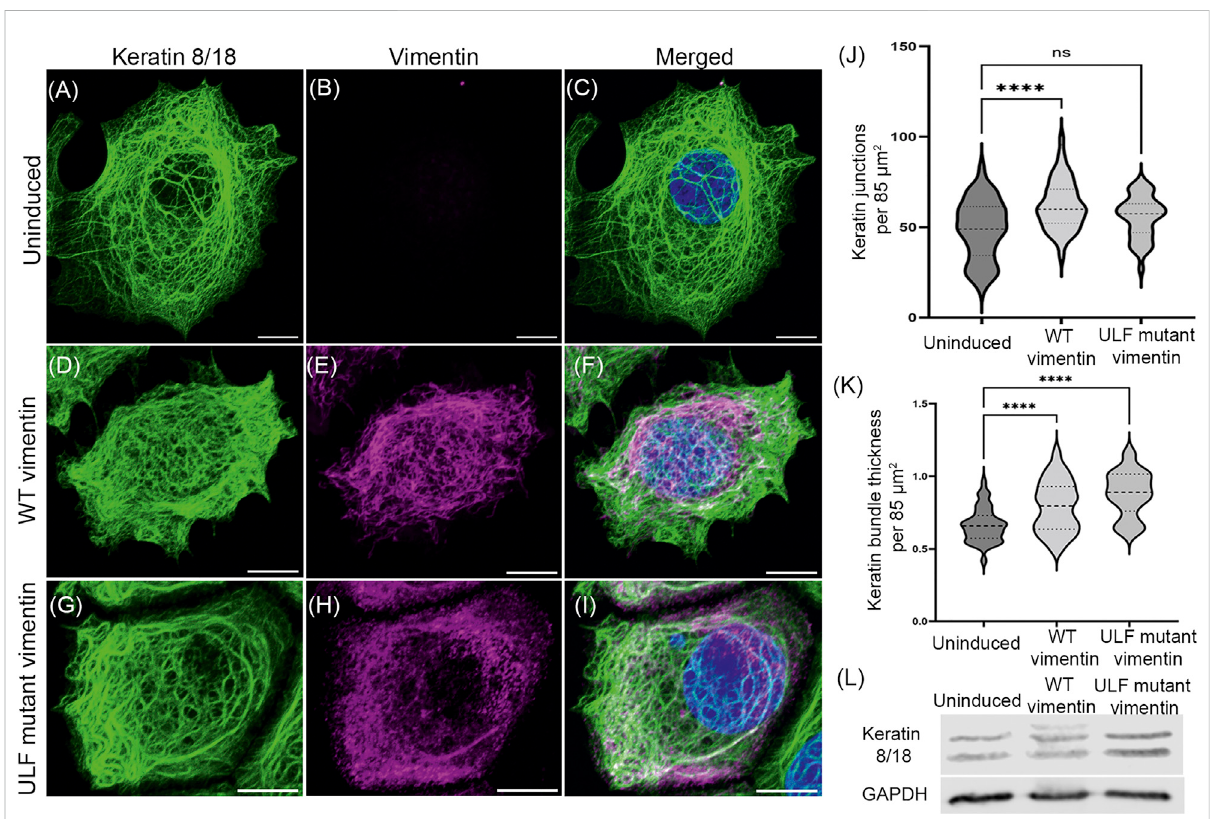
FIGURE 2 Vimentin expression does not alter the endogenous expression of keratin in MCF7. Immuno fl uorescence images of keratin 18 (A, D and G) and vimentin (B,E andH) inuninduced MCF7 cells (A – C) ,WT vimentin ininducedMCF7 cells (D – F) and ULFmutant vimentin inMCF7 cells (G – I) . Figures C,Fand Ishow theoverlay ofkeratin18and vimentin in therespective cells. Scalebar is10 μ m. (J) Graph showing thenumber ofkeratinjunctions in uninduced MCF7 and in cells expressing either WT vimentin or ULF mutant vimentin. (K) Graph showing the keratin bundle thickness in uninduced MCF7 cells and following the induction of WT vimentin or ULF mutant vimentin. (L) Western blot showing the expression levels of keratin 8/18inuninducedMCF7,MCF7 cellsexpressingWT vimentinorULFmutantvimentin. GAPDHisusedasloadingcontrol.One-way ANOVA wasused to compare the differences between the groups. **** p < 0.0001. All the experiments were done on cells sorted for GFP expression 5 days post induction with